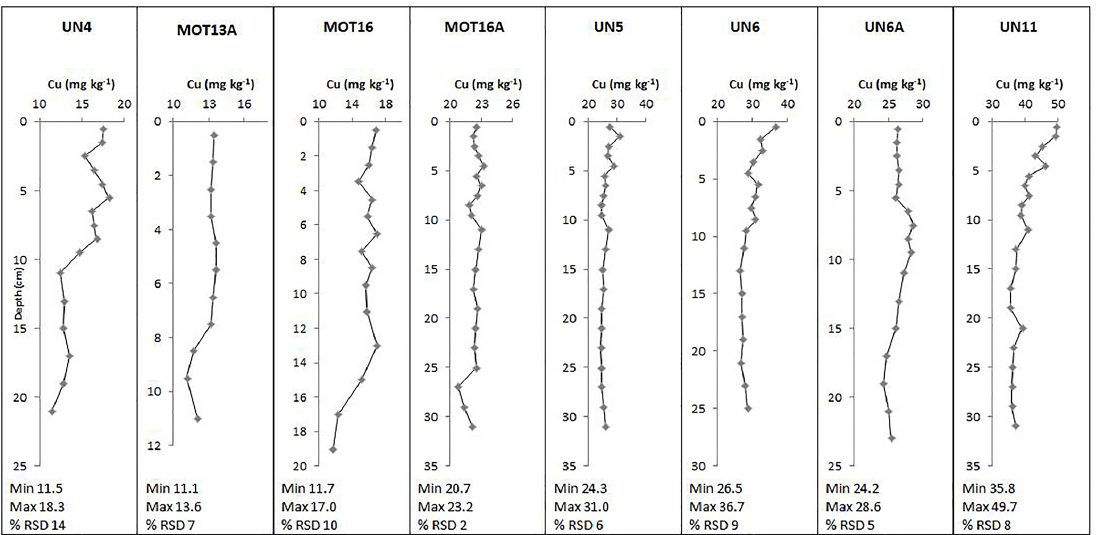
Figure A10. Vertical distributions of Cu (in mgkg − 1 ) in sediment cores. The concentrations in the coarse cores MOT13A, MOT16 and UN4 refer to the total sediment fraction ( <